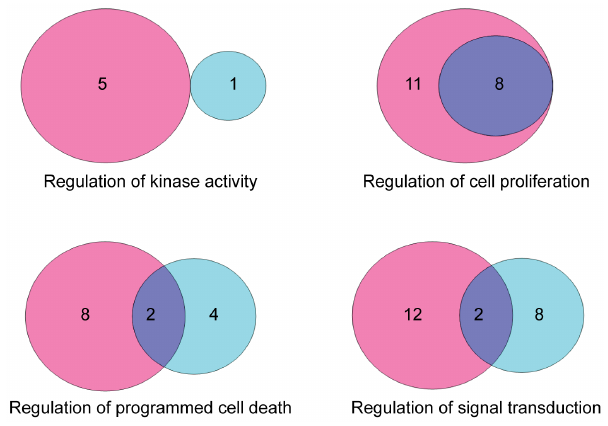
Figure 3. Differential regulation of specific annotations in DAVID. Selected annotations were analyzed to examine the manner in which the specific pathway is regulated. Venn diagrams show the number of mice in which the pathway showed negative (cyan), positive (pink), or both negative and positive regulation (purple).